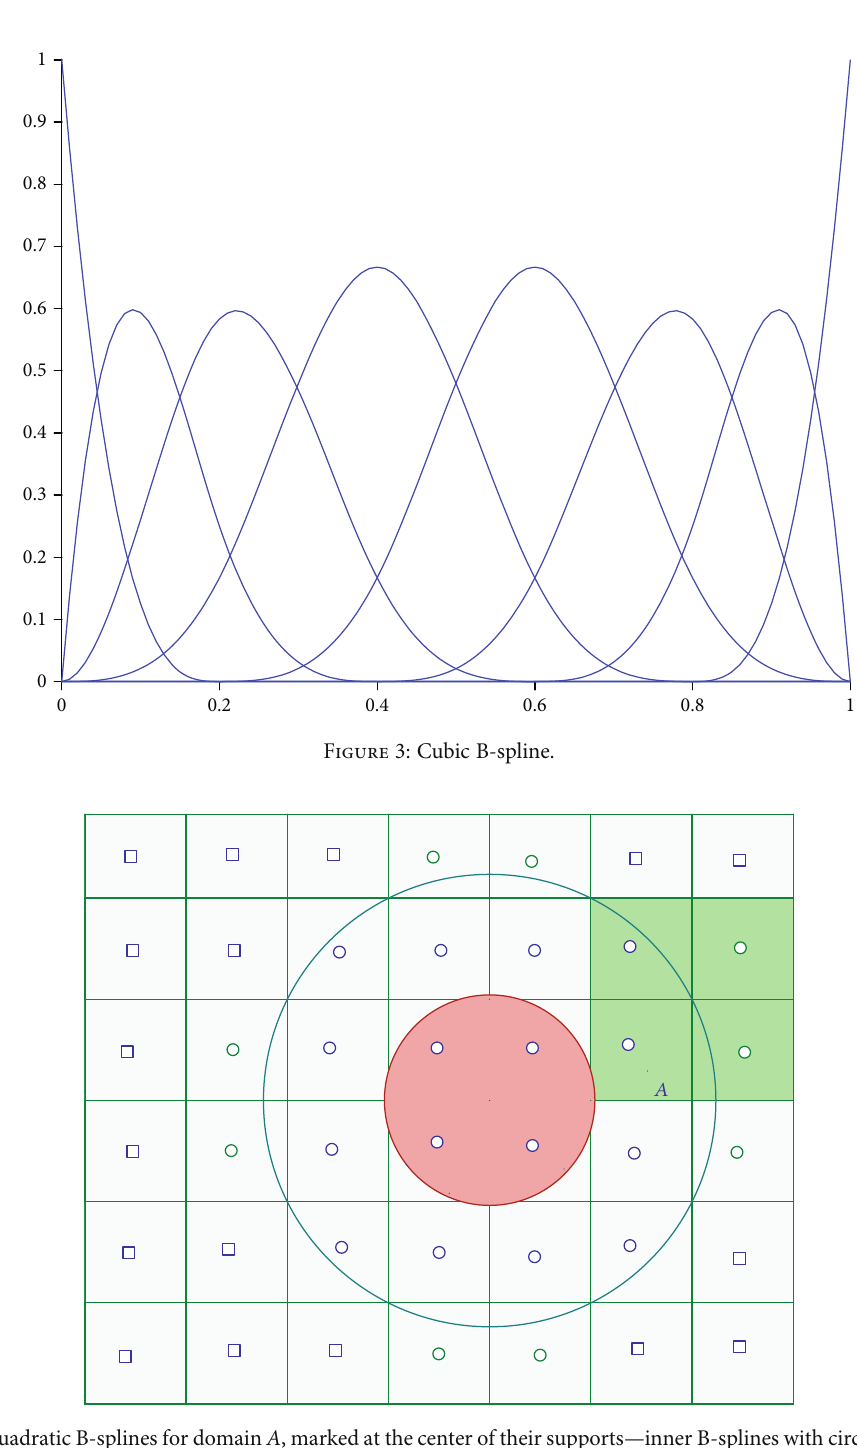
Figure 4: Relevant quadratic B-splines for domain A , marked at the center of their supports — inner B-splines with circles and outer ones with